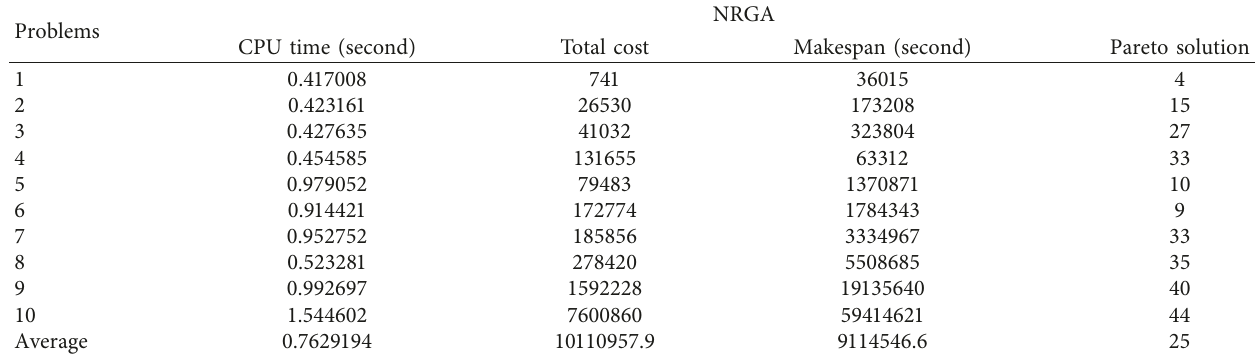
Table 11: Superior performance of each problem based on SAW method for NRGA.